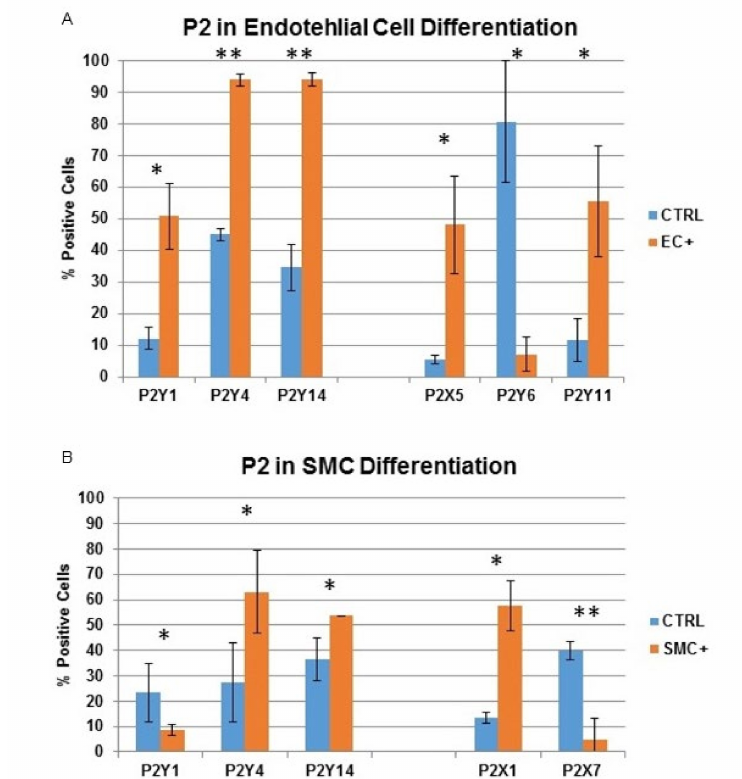
Figure 4. Indirect flow cytometry analysis of P2 receptor expression after endothelial and smooth muscle cell di ff erentiation. ( A ) P2 receptor expression of undi ff erentiated and endothelial cell di ff erentiated MSC after 7 days (P2Y1, P2Y4 and P2Y14) and after 14 days (P2X5, P2Y6 and P2Y11); ( B ) P2 receptor expression of undi ff erentiated and smooth muscle cell di ff erentiated MSC after 7 days (P2Y1, P2Y4 and P2Y14) and after 14 days (P2X1 and P2X7). (* p < 0.05; ** p <